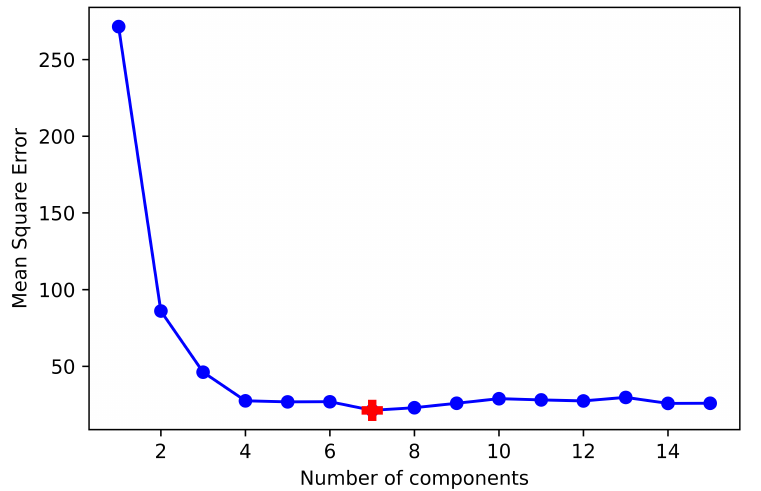
Figure 2. Mean square error as a function of the number of latent variables (without variable selection for nitrogen